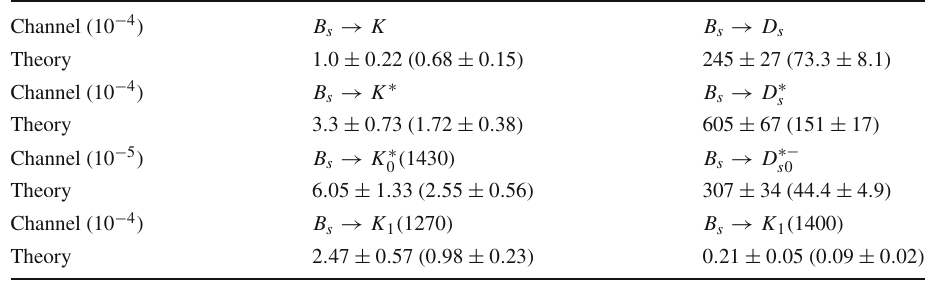
2 . 47 ± 0 . 57 (0 . 98 ± 0 . 23) 0 . 21 ± 0 . 05 (0 . 09 ± 0 . 02)